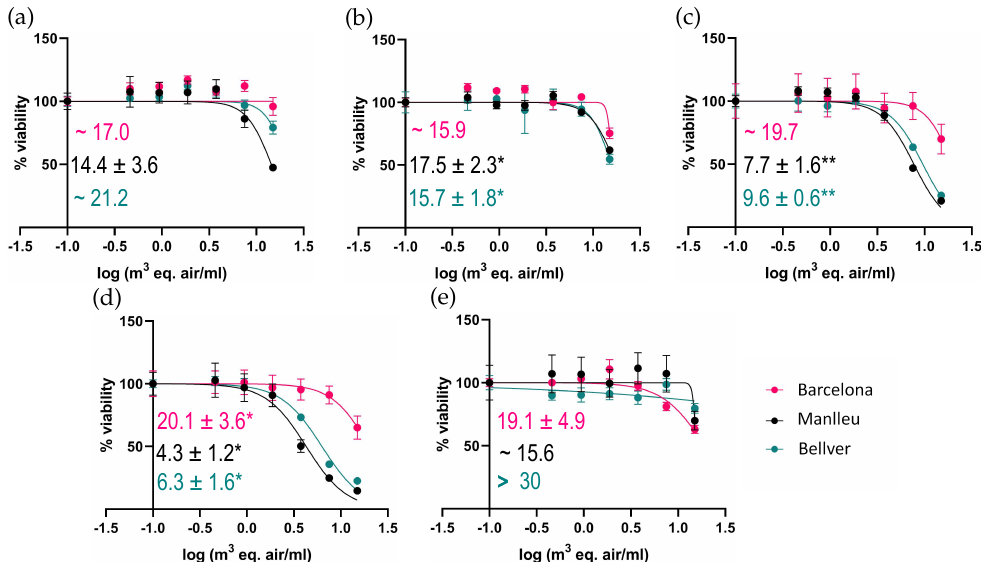
Figure 8. Toxicity curves and IC50 values (in m 3 eq./mL) for each day and station. ∼ indicates approximate results, very wide IC50 slopes. * indicates slope fitting parameter R 2 > 0.96. ** indicates slope fitting parameter R 2 > 0.99 ( a ) 02/08/2019, ( b ) 16/11/2019, ( c ) 20/11/2019, ( d ) 18/12/2019, ( e )